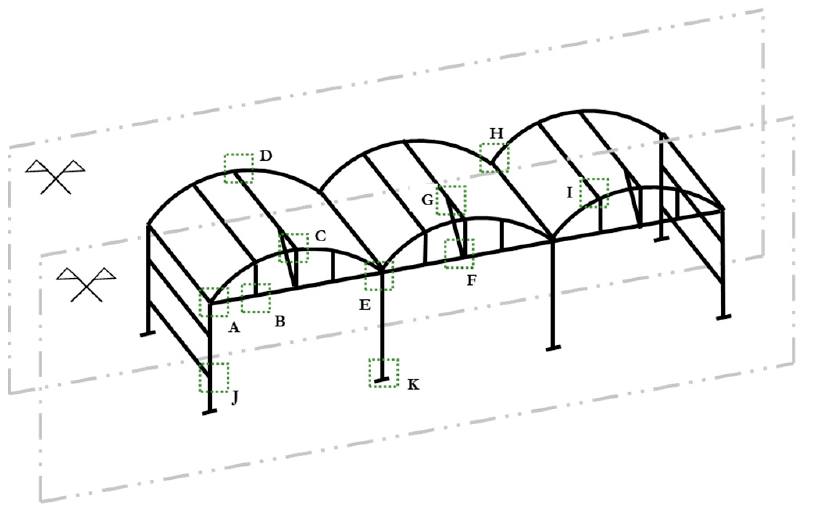
Figure 7. Codification of the di ff erent nodes in the greenhouse structure.